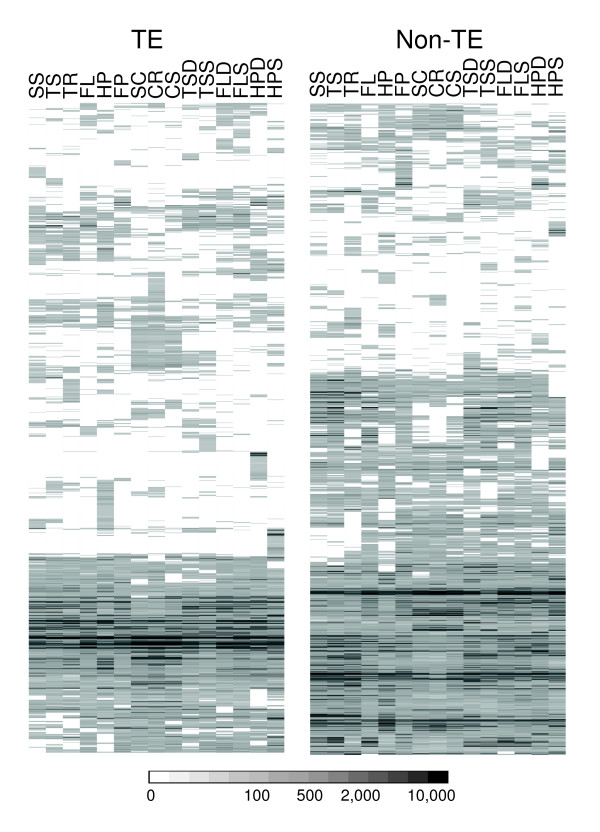
Global expression map showing transcriptional activity of TE-related and randomly selected non-TE-related genes. Only 1,353 TE-related genes with transcription in at least one sample are included. Another 1,353 non-TE-related genes randomly picked from those with transcription in at least one samples are shown in parallel. Each lane represents one sample in the same order as in Table 2. Shades of gray indicate the magnitude of transcription signals, which are based on microarray hybridization signals without units. TE, transposable element.